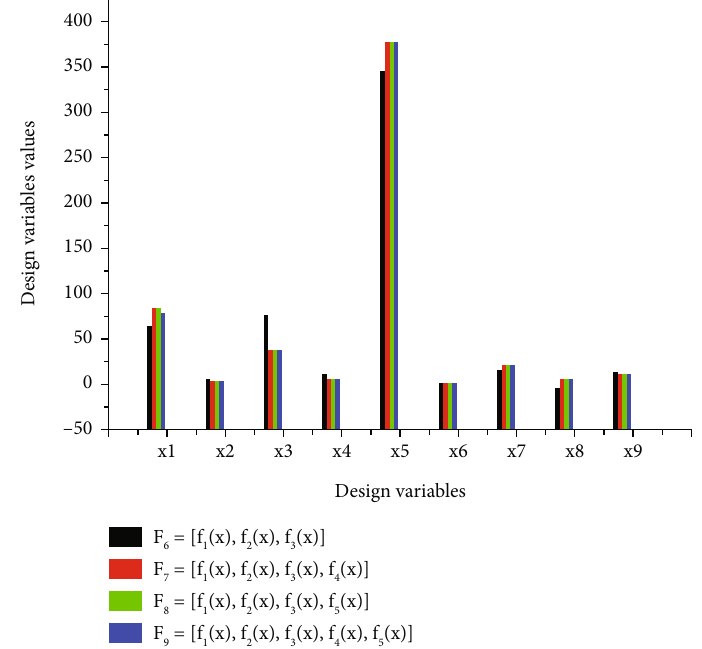
Figure 5: Optimal design variables versus multiobjective optimization of